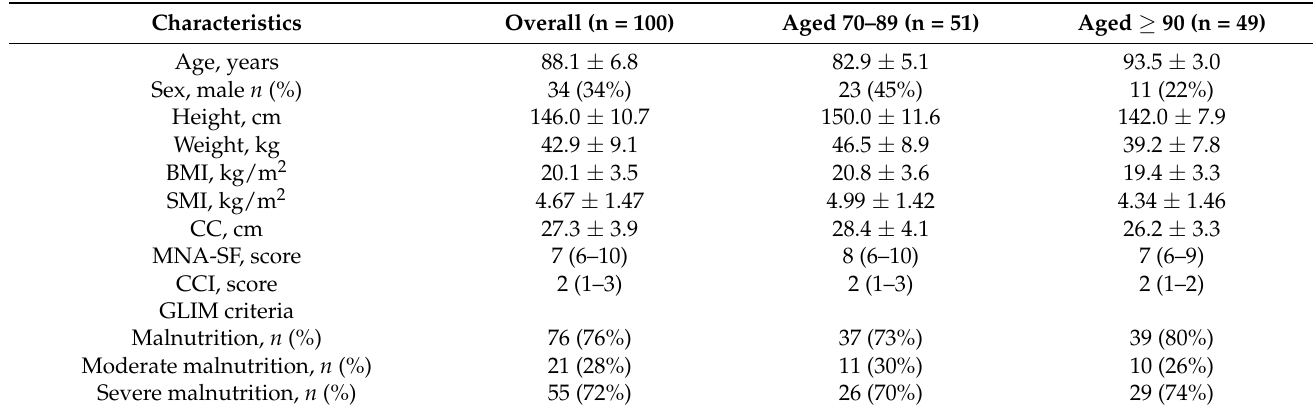
Table 2. Clinical characteristics of the studied